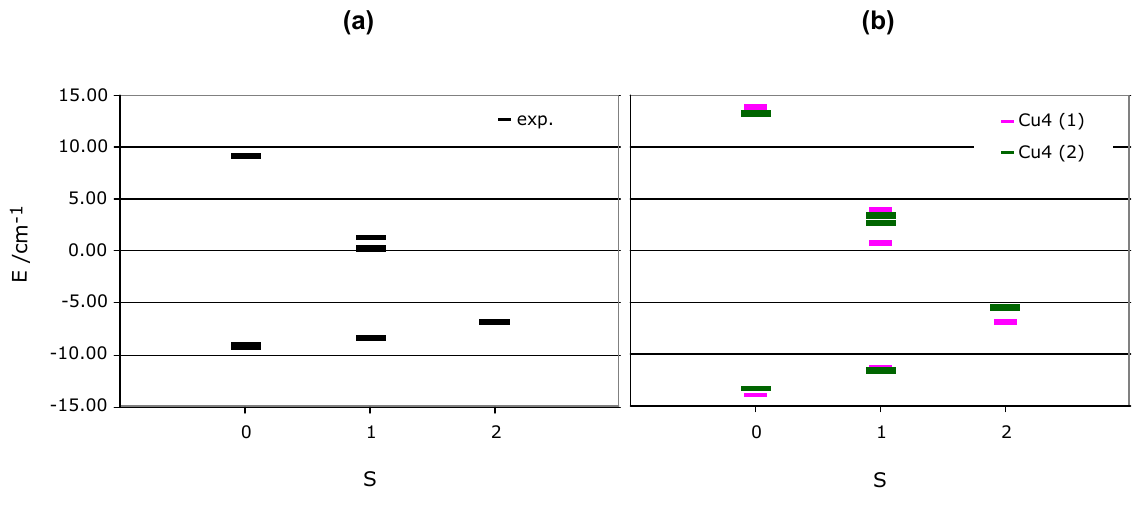
Figure 6 . Representation of the relative energy of the six possible states in which one can place the four electrons present in the Cu II tetramers of Figure 2a-b. We have plotted in (a) the states computed when using the experimental J parameters (in black), and in (b) those obtained using the J parameters for each tetramer (in purple for tetramer 2a and green for